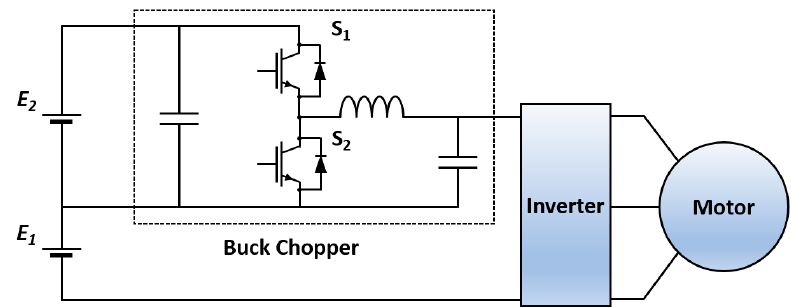
Figure 2. Powertrain of the two-battery High-Efficiency Energy Conversion System (HEECS) chopper.